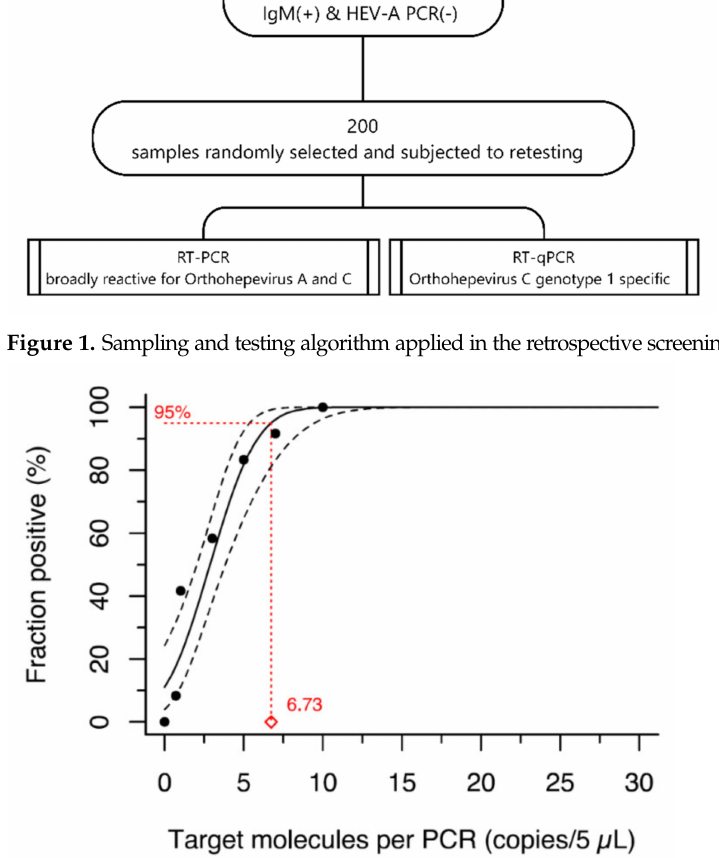
Figure 2. Limit of detection (LoD) 95 of HEV-C1 specific PCR based on strain R63/DEU/2009 plasmid as determined by probit